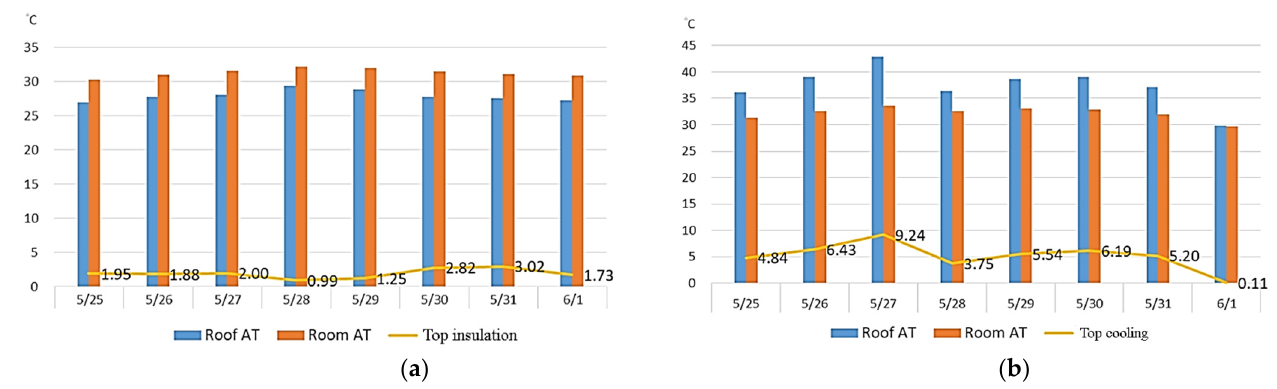
Figure 9. Comparison of the shading effect of the ecological terrace on the building during ( a ) 04:00– 05:00 and ( b ) 12:00–13:00.